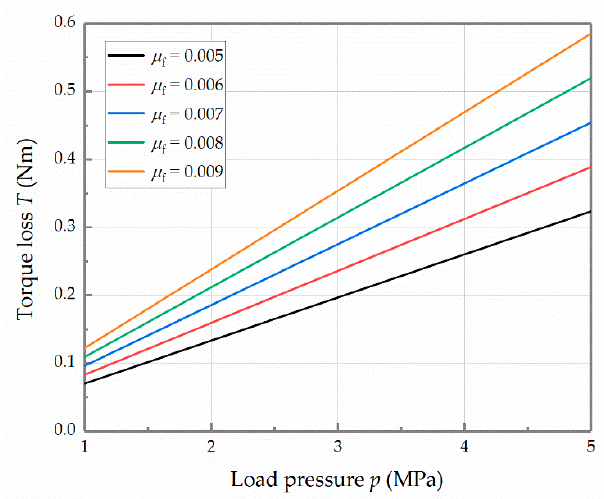
Figure 14. Curves of the torque loss with respect to the load pressure at different friction coefficients.